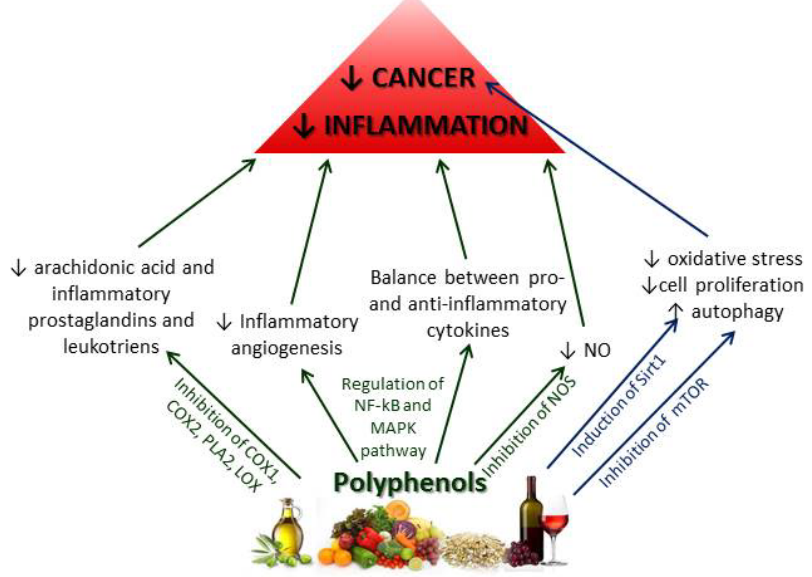
Figure 3. Polyphenols control and reduce inflammation through a series of pathways preventing cancer and other age-related diseases with an inflammatory